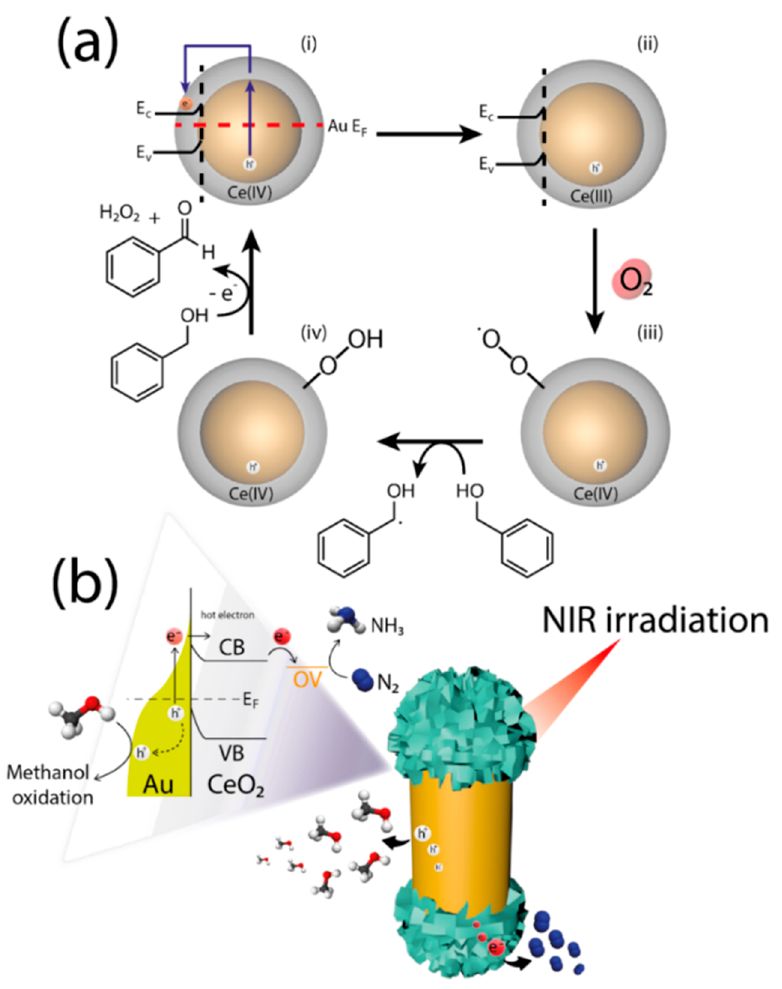
Figure 5. ( a ) Hot electron injection mechanism for a core-shell Au@CeO 2 configuration (adapted from [21]). Hot electrons generate Ce (III) species that can capture and activate O 2 which furtherly reacts